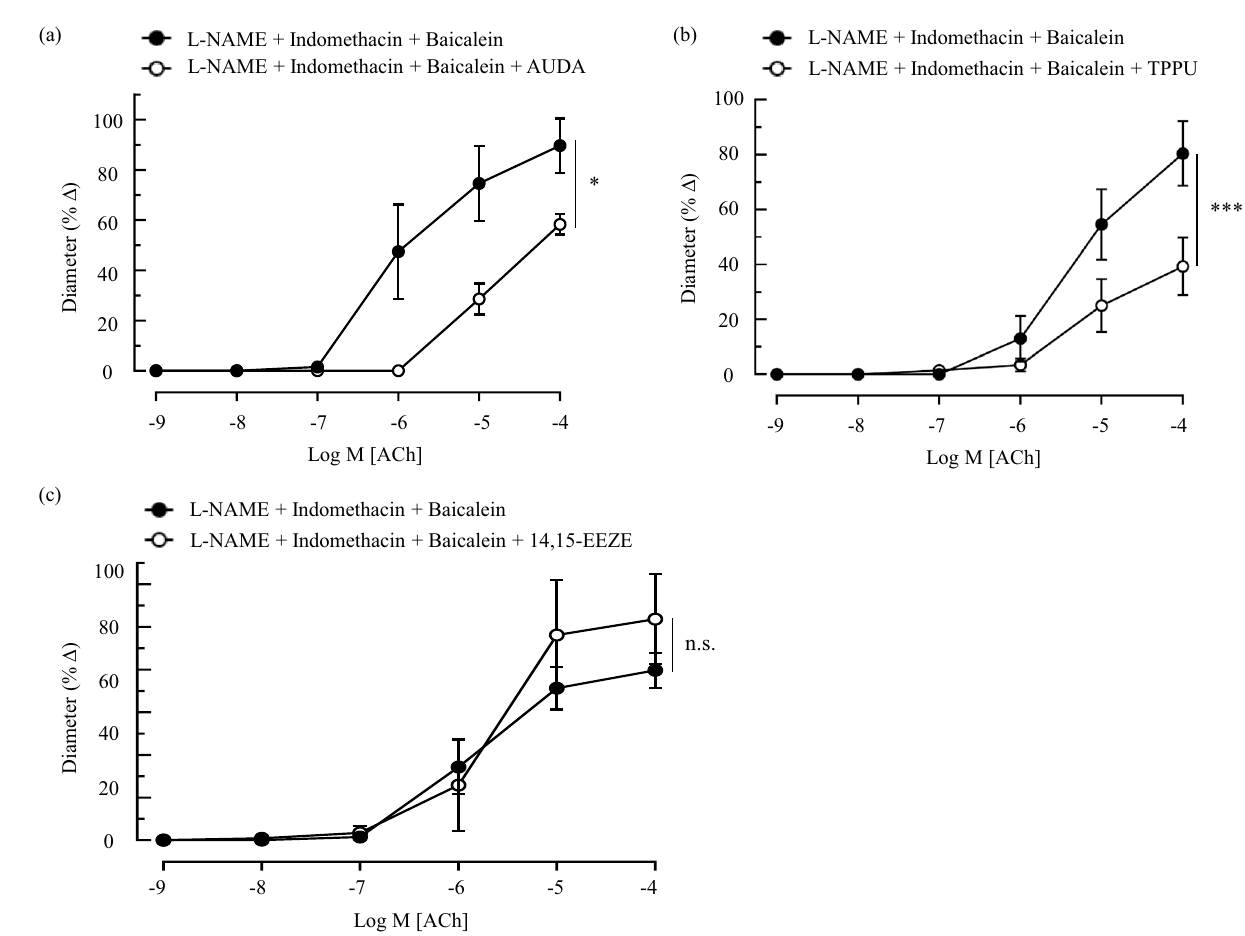
Figure 4. Changes in the vasoreactivity of ophthalmic artery in response to the inhibition of EET catalysis and direct antagonism of EETs. The administration of 100 nmol/L of sEH inhibitors comprising ( a ) AUDA and ( b ) TPPU resulted in significant reduction of vasodilation, whereas the selective inhibition of EETs with ( c ) 14, 15-EEZE (10 µmol/L) showed a noticeable increment in the pre-constricted vascular diameter albeit not statistically significant. Values are expressed as mean ± s.e.m, n = 6 per group. Absence of error bar indicates that the s.e.m was less than the size of the symbol. * P < 0.05; *** P < 0.001, n.s. non-significant, vs. L-NAME + indomethacin +